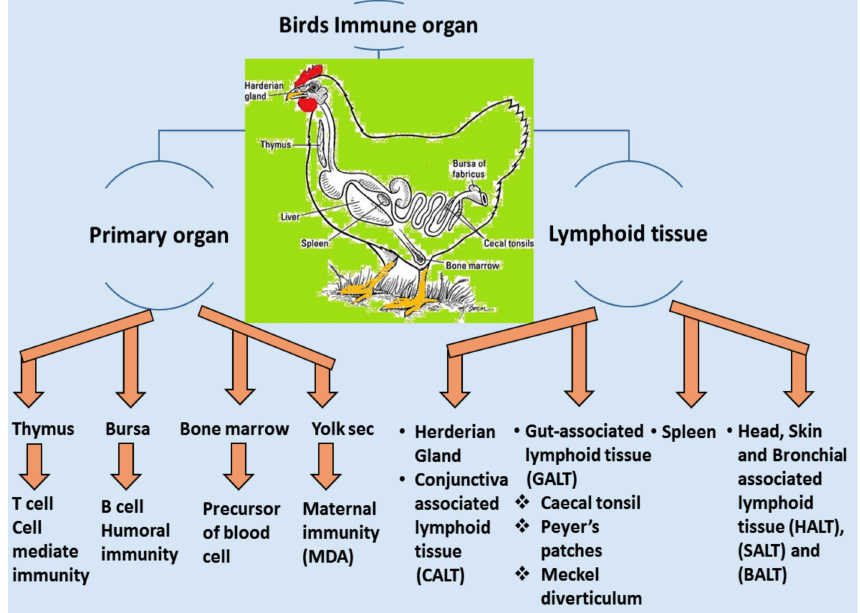
Figure 4. The primary and secondary lymphoid organs enmeshed in the immune complex where the mature B and T cells are transferred from primary or lymphoid tissue for the development stage term as immune movement or immune